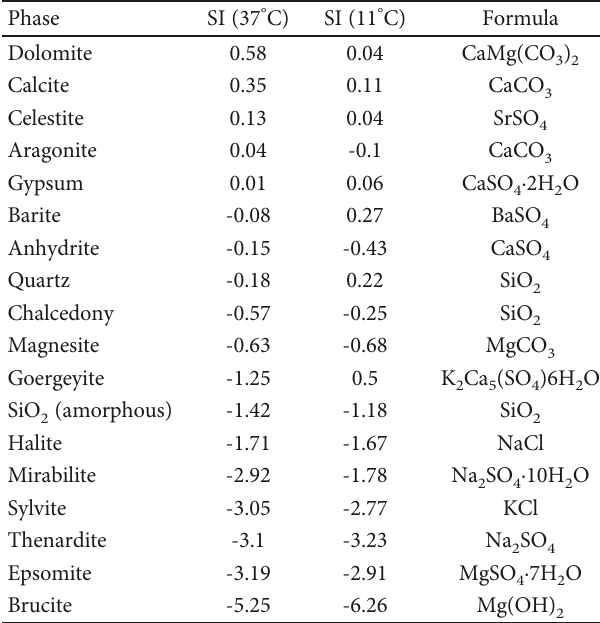
Table 5: Calculated saturation indices for the Klaipeda 2P brine sampled on 1/4/16, at 37 ° C and 11 ° C, using PHREEQC Interactive version 3.3.5 [29] and the Pitzer thermodynamic